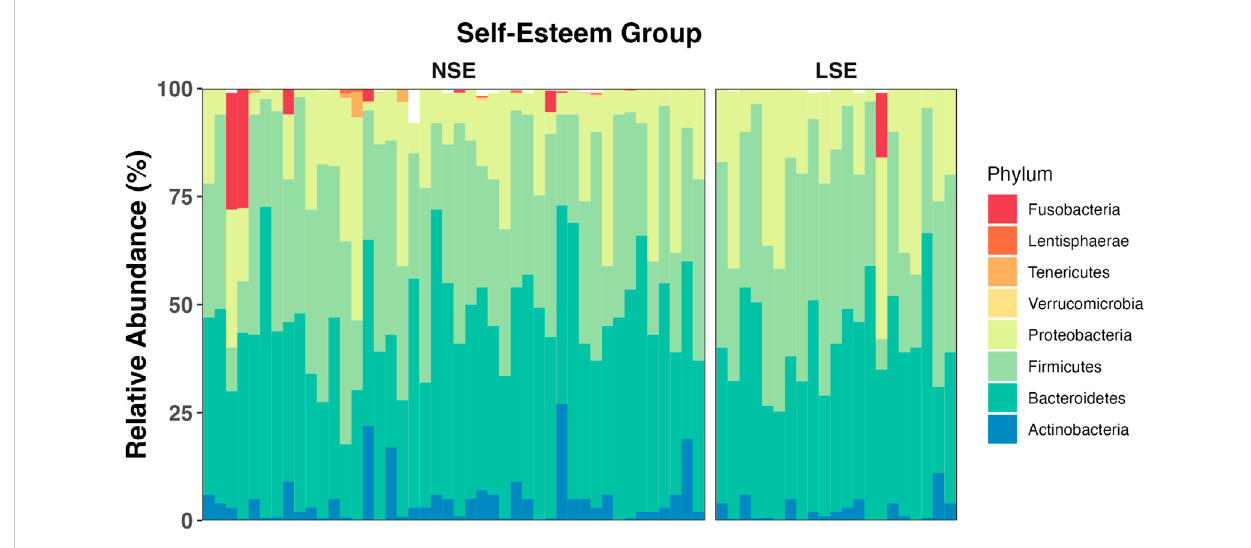
FIGURE 3 Average relative abundance of gut bacterial phyla across SE groups. Bacterial phyla Bacteroidetes , Firmicutes , Proteobacteria , and Actinobacteria (amongunclassi fi edbacteria)composeanaverageofroughly 97%ofthegutbacterialpopulation ineachgroup.Theremaining3%ofthegutbacteria are largely composed of members belonging to Verrucomicrobia , Tenericutes , Lentisphaerae , and Fusobacteria . The mean relative abundance of bacterial phyla is represented for NSE and LSE groups, and for each individual participant.